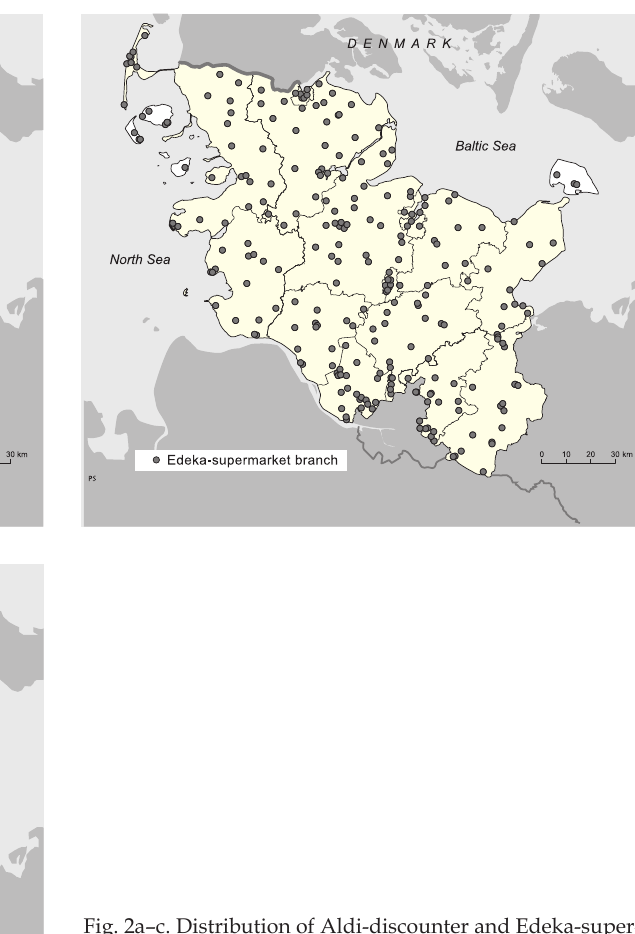
Fig. 2a–c. Distribution of Aldi-discounter and Edeka-super - market branches and their strategic cluster development (max. distance 150 m), the province of